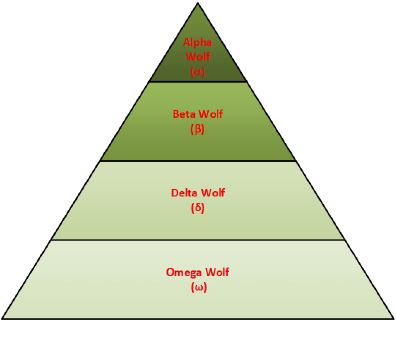
Figure 3. The hunting hierarchy of grey